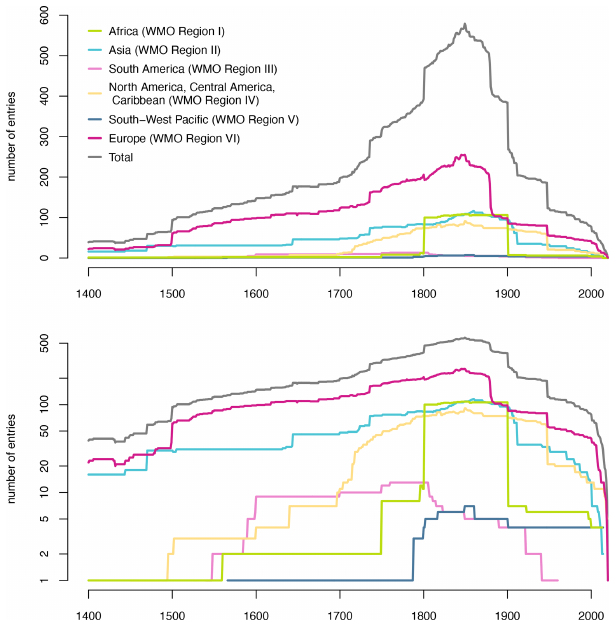
Figure 2. Number of available documentary series related to cli- mate as a function of time and region. The bottom panel depicts available series with logarithmic scaling of the y